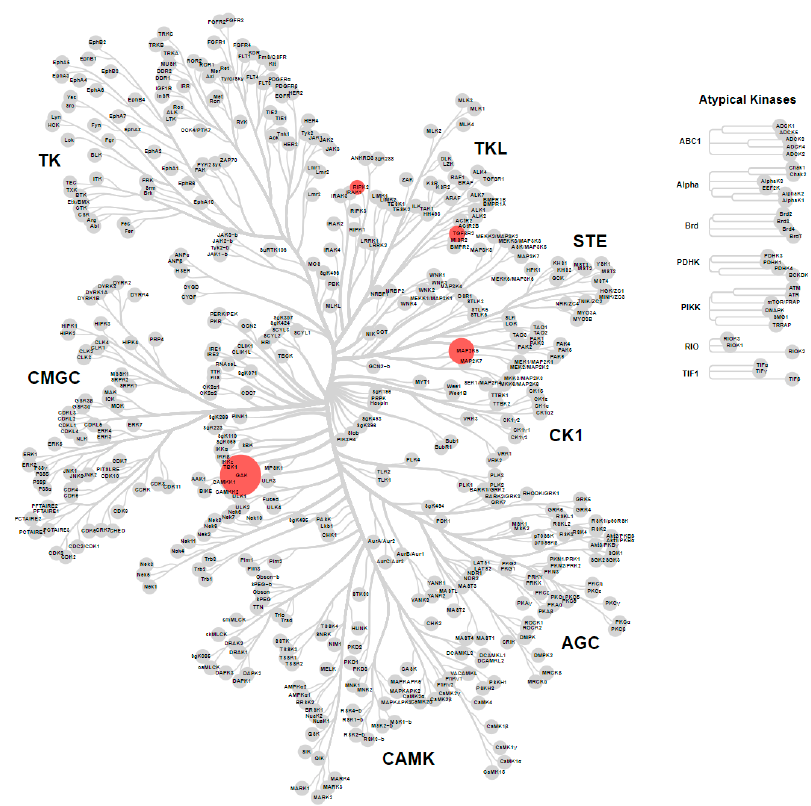
Figure 6. Representation of the human kinome based on sequence identity-displaying KinomeScan results for 35 screened at 1 µ M. Red dots represent hits di ff erentiated by size; kinases inhibited at 1 µ M GAK, 90%; MEK5, 89%; TGFBR2, 82%; RIPK2, 71% (see Supplementary